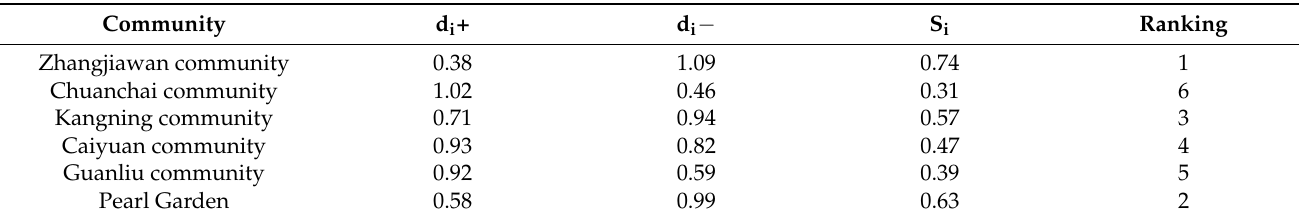
Table 8. Closeness degree and